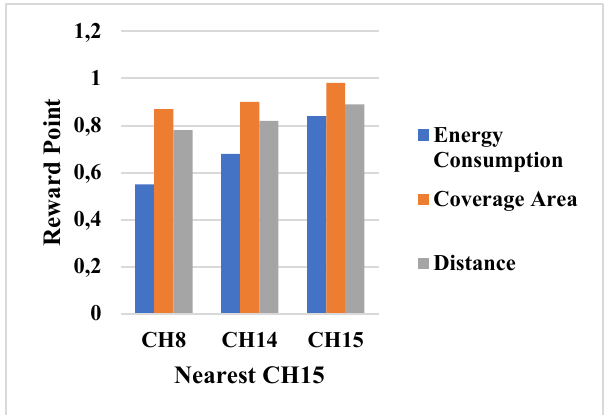
Figure 14. Reward point for Energy Consumption, Coverage Area, and Distance